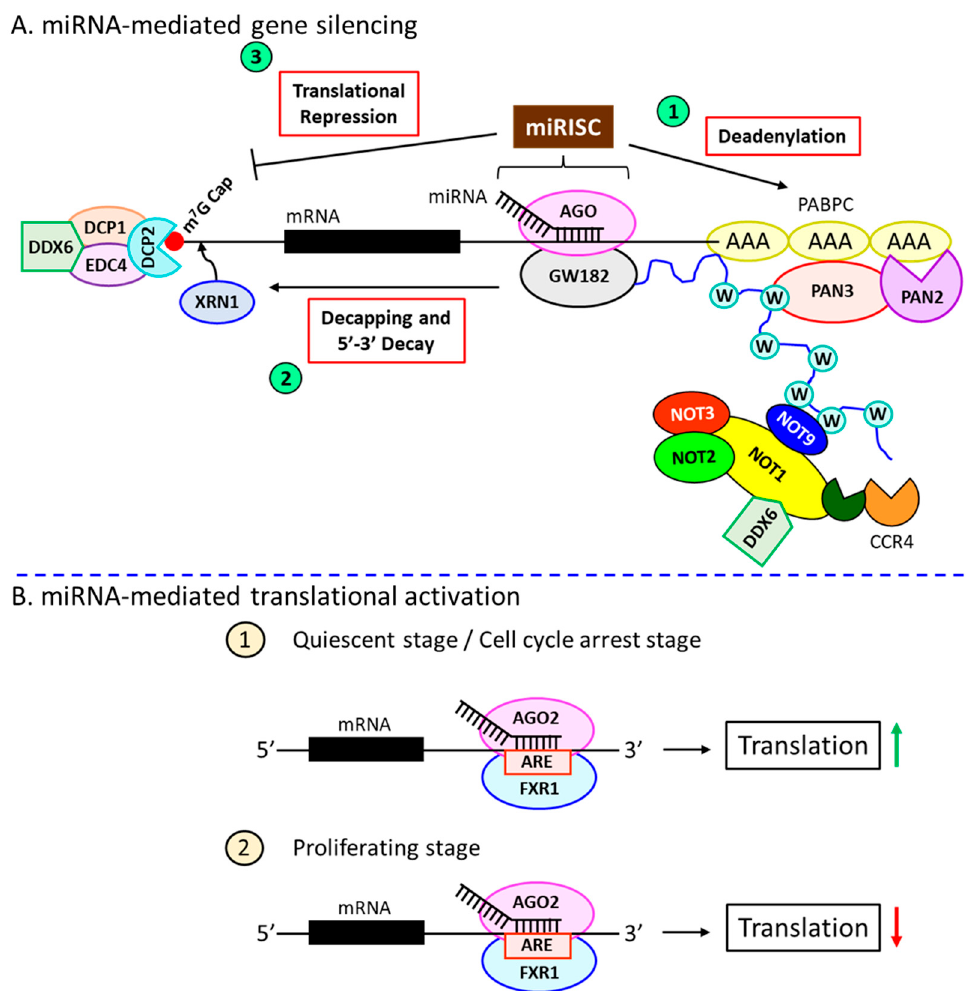
Figure 2. miRNAs-mediated gene regulation. ( A ) miRNA-mediated gene silencing mechanisms. miRNA-dependent gene silencing occurs in three independent pathways. miRNA-bound AGO forms the miRISC complex, which plays a central role in gene regulation. 1 (cid:13) miRISC recruits the scaffolding protein, GW182, which further recruits effector complexes PAN2-3 and CCR4-NOT to induce the deadenylation process. Deadenylation is enhanced by the interaction among GW182, PABPC,